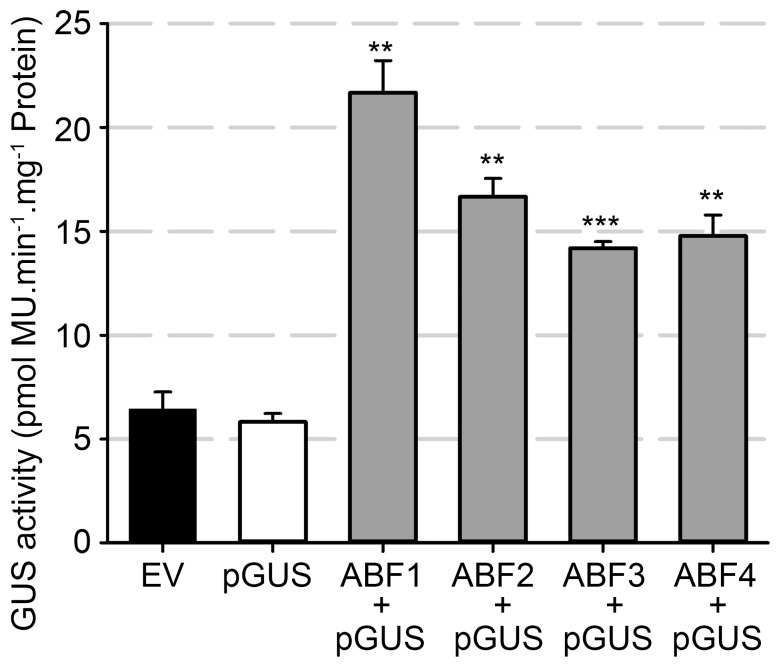
The PLAT1 promoter is activated by the ABF transcription factors.GUS activity in 8-w-old N. benthamiana leaves infiltrated with A. tumefaciens harbouring the PLAT1:PLAT1-GUS reporter (pGUS) or an empty vector (EV) as negative control, compared to the simultaneous infiltration of the 35S:ABF1–4 and PLAT1:PLAT1-GUS constructs. Values are means of 3 replicates ± standard deviation. *** or ** indicate statistical significance calculated using the unpaired Student's t-test at p<0.001 or p<0.01, respectively.